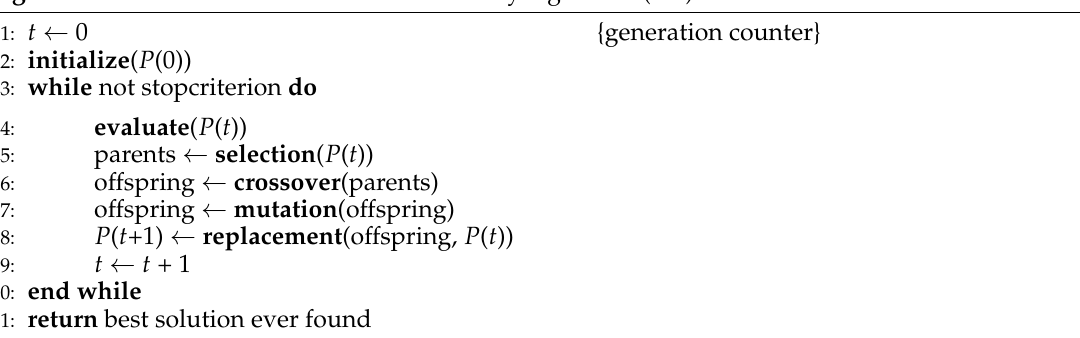
Algorithm 1 Generic schema for an evolutionary algorithm